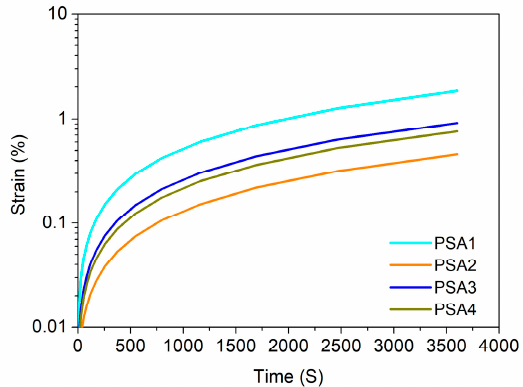
Figure 9. Creep curves of four WPU-PSAs at 25 °C under stress of 1 Pa.